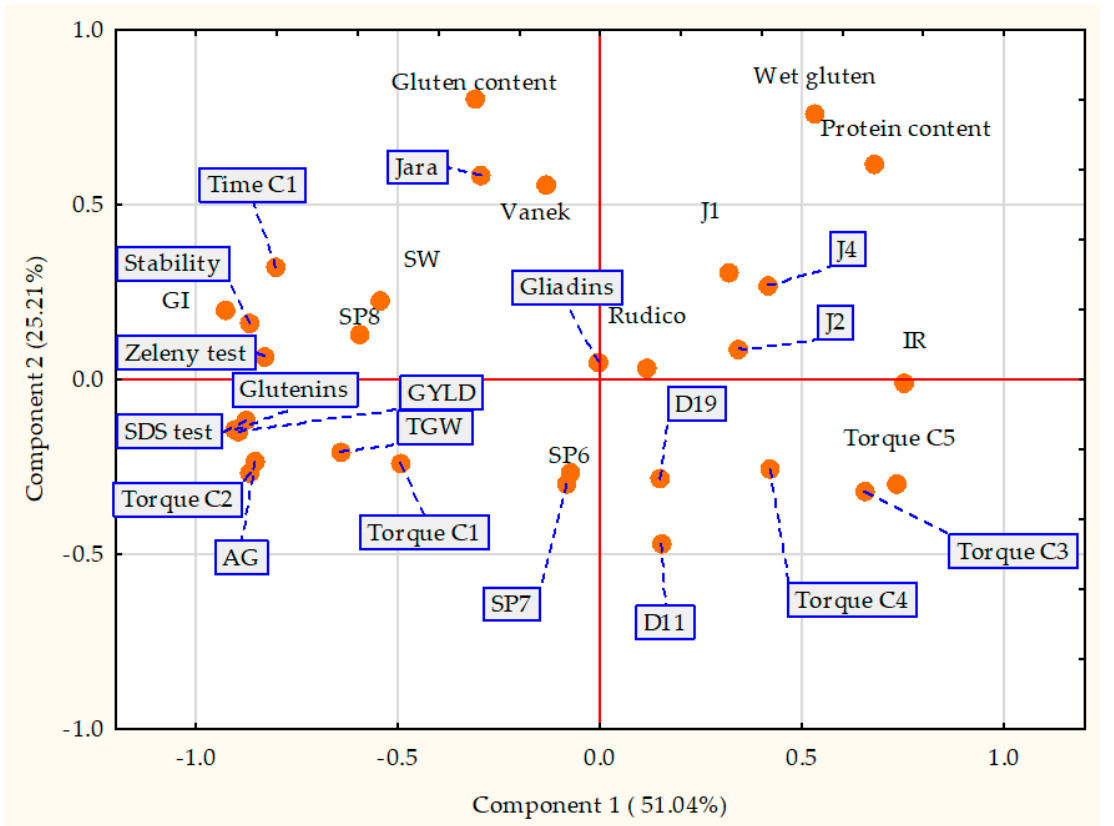
Figure 6. Principal component analysis biplot based on various physicochemical parameters of wheat varieties using mean value of three locations. AG: Albumins and globulins; IR: Insoluble remainder; FN: Falling number.